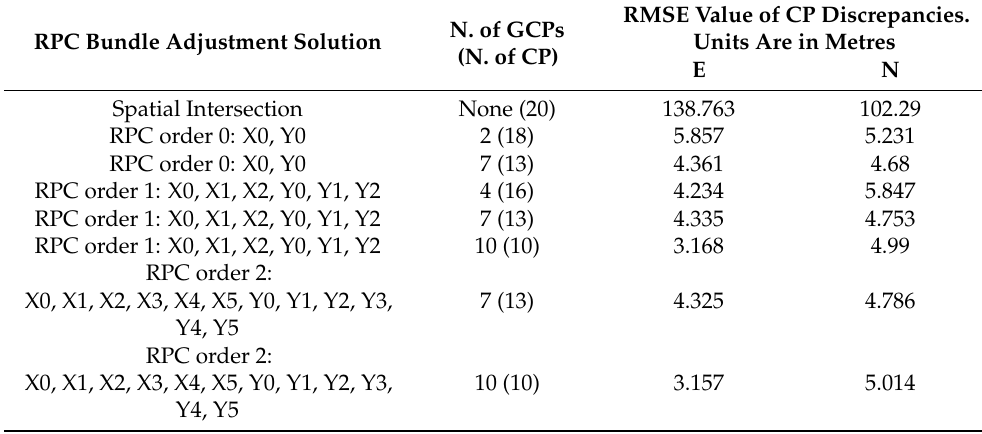
Table 8. Results of RPC bundle adjustment with bias compensation for small-central area of Rome.